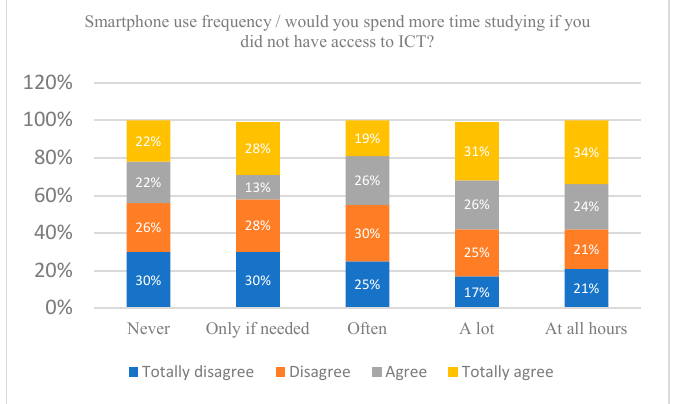
Figure 1. Interference of the frequency of use of the Smartphone in the time dedicated to studying. Note: The figure shows how smartphone use frequency is related to the time teenagers dedicate to study. Axis Y: Would you spend more time studying if you did not have access to the Internet? Axis X = Smartphone use frequency.